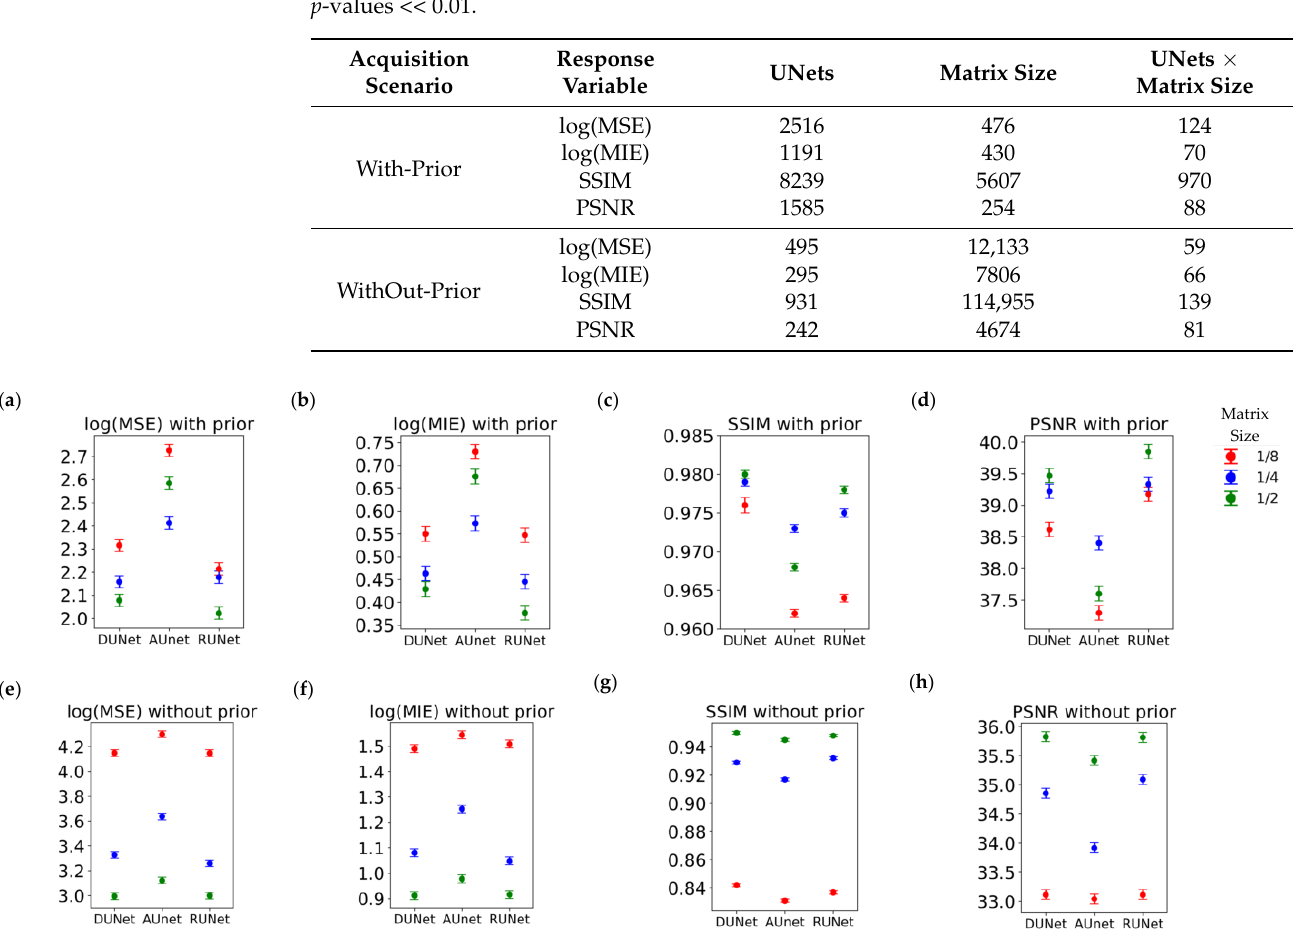
Figure 9. Interaction plots for the mixed-effects model, indicating how the two factors—UNets and Matrix Size—interact with each other under ( a – d ) the With-Prior acquisition scenario ( a ) log(MSE), ( b ) log(MIE), ( c ) SSIM, and ( d ) PSNR; and under ( e – h ) the WithOut-Prior acquisition scenario ( e ) log(MSE), ( f ) log(MIE), ( g ) SSIM, and ( h ) PSNR.